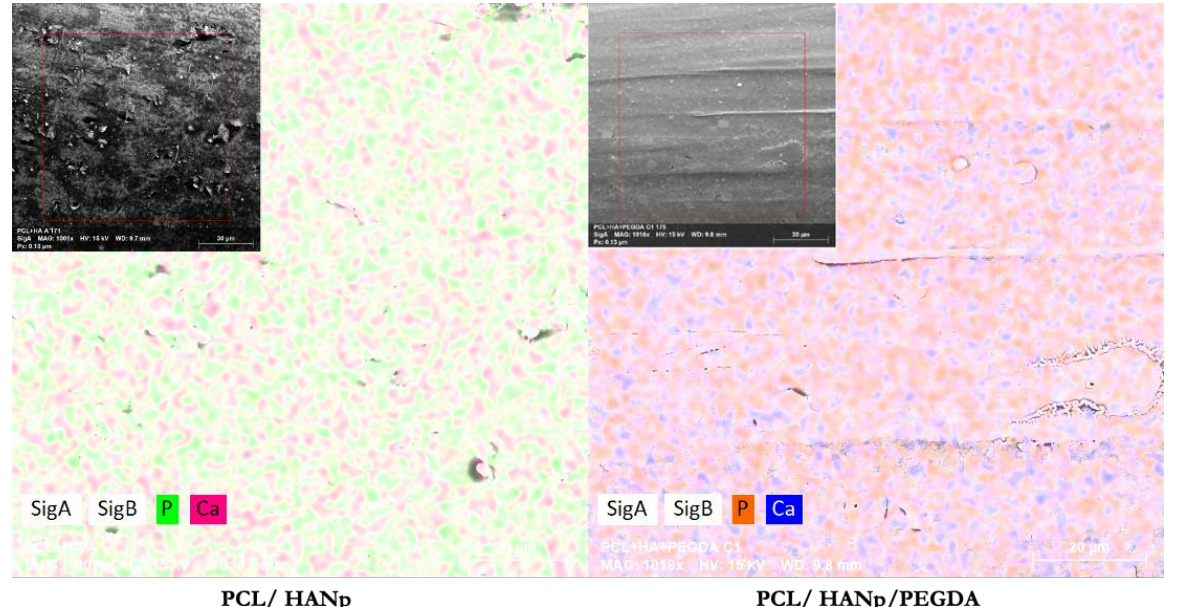
Figure 7 . EDX Si-mapping micrographs. Figure 7. EDX Si-mapping